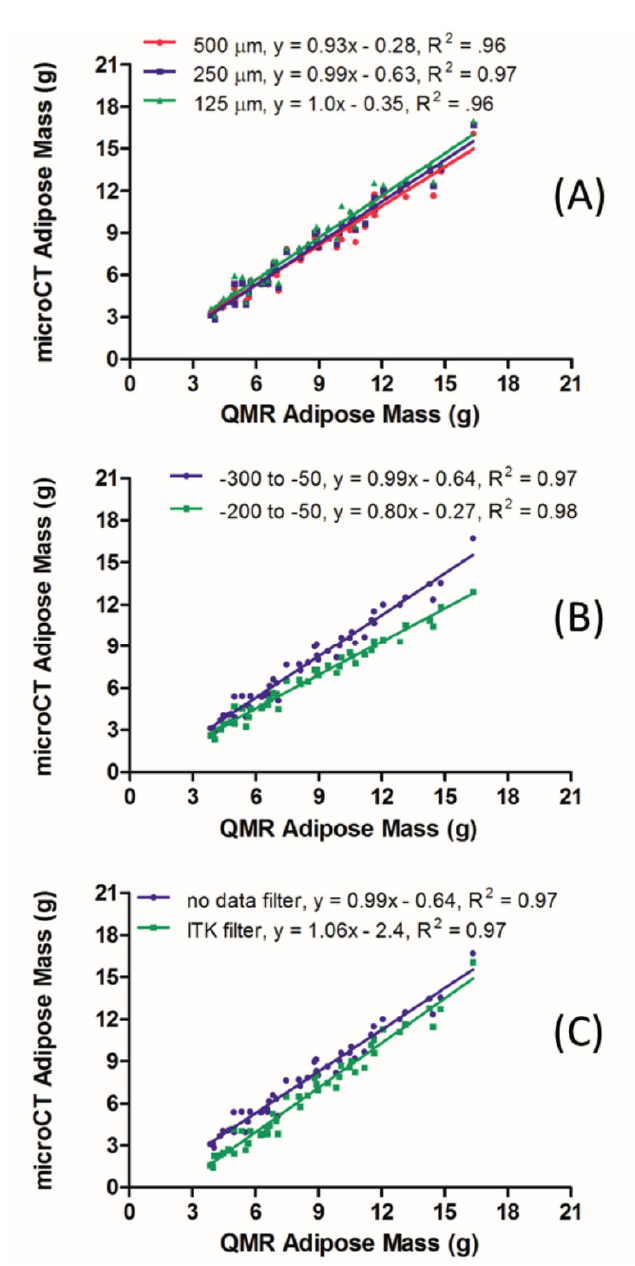
Figure 2. Effects of resolution ( Panel A ), segmentation range ( Panel B ) and median filter ( Panel C ) on microCT data alignment with